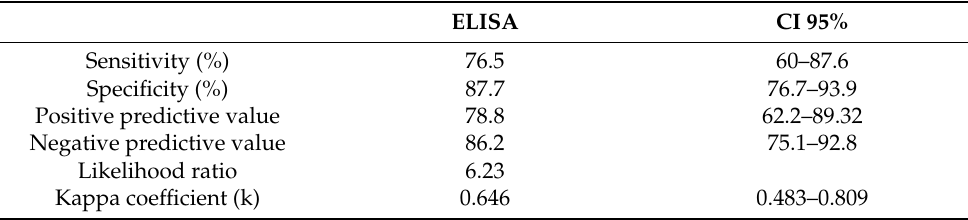
Table 3. Comparison of the ELISA to MAT to detect Toxoplasma gondii antibodies in a cohort of 91 serum of hunting dogs (descriptive test parameters and measures of